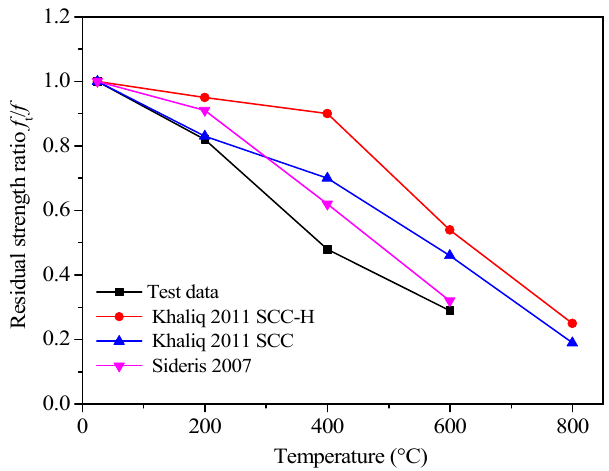
Figure 3. The relationships between the residual tensile strength factor and temperature.